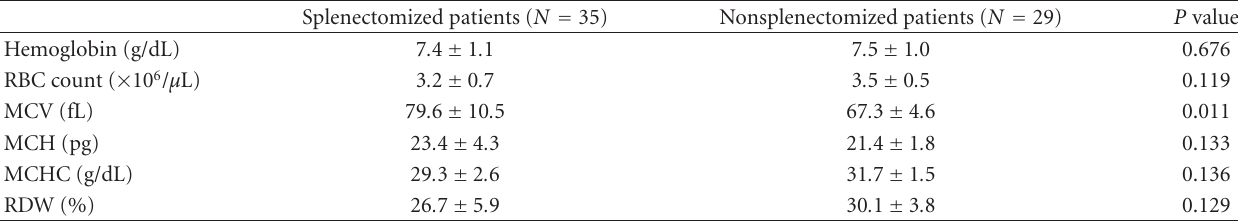
Table 1: Hematologic parameters of β -thalassemia/HbE